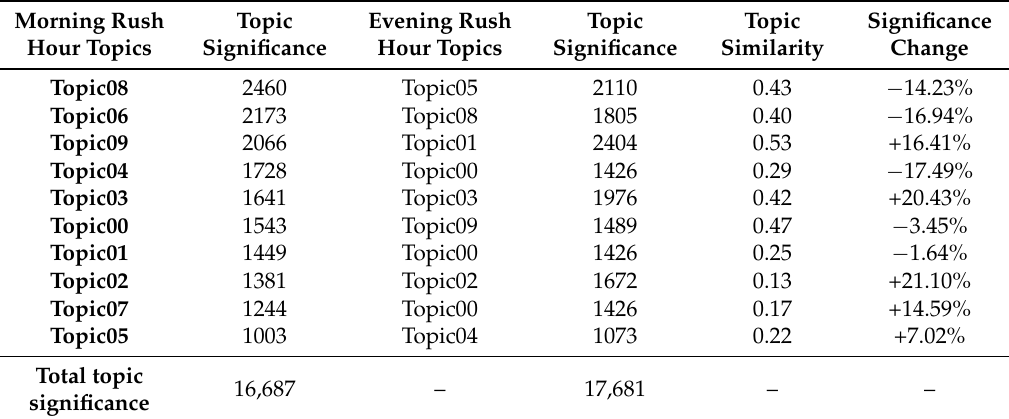
Table 5. Temporal evolution of trip